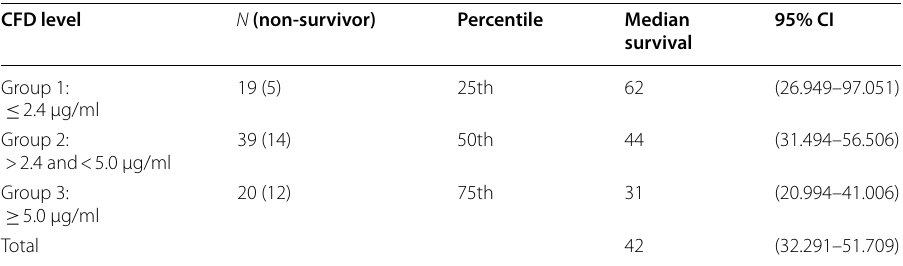
Table 3 Association of complement factor D levels to in-hospital mortality CFD level N (non‑survivor) Percentile Median